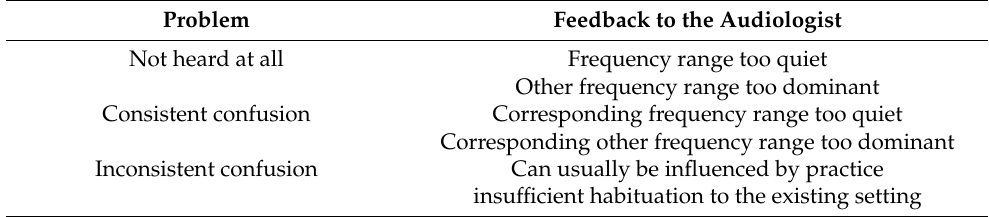
Table 2. Problems of sound differentiation and omission.